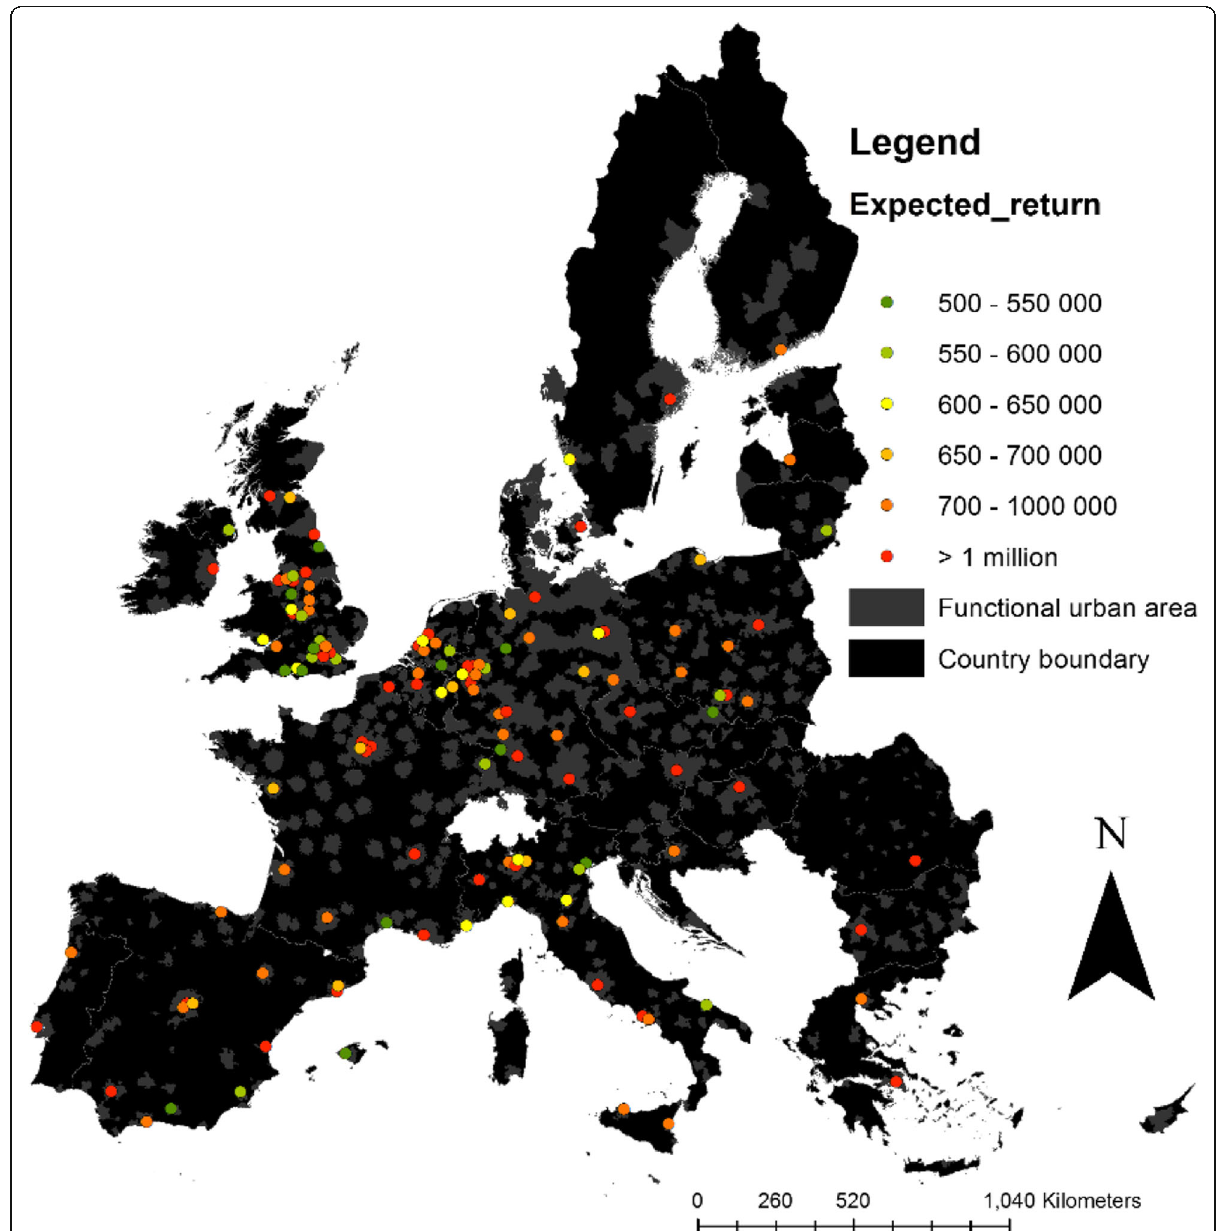
Fig. 14 Spatial distribution of hives for Scenario 3 under 6 different economic viability